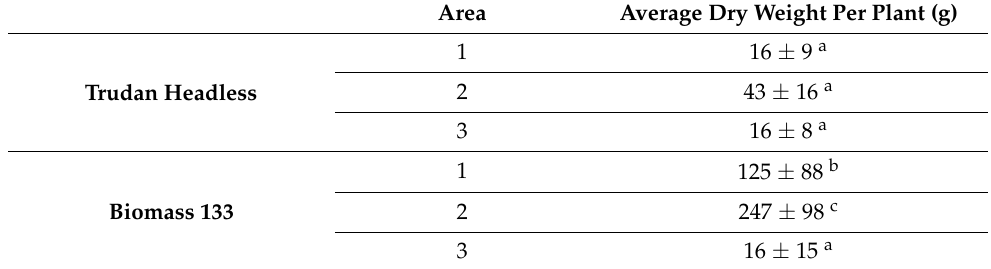
Table 2. Average dry weight by plant of the 2 sorghum cultivars sampled at harvest for the 3 areas (10 samples by area, mean + SD). Significant differences between conditions are indicated by different letters at the level of α =